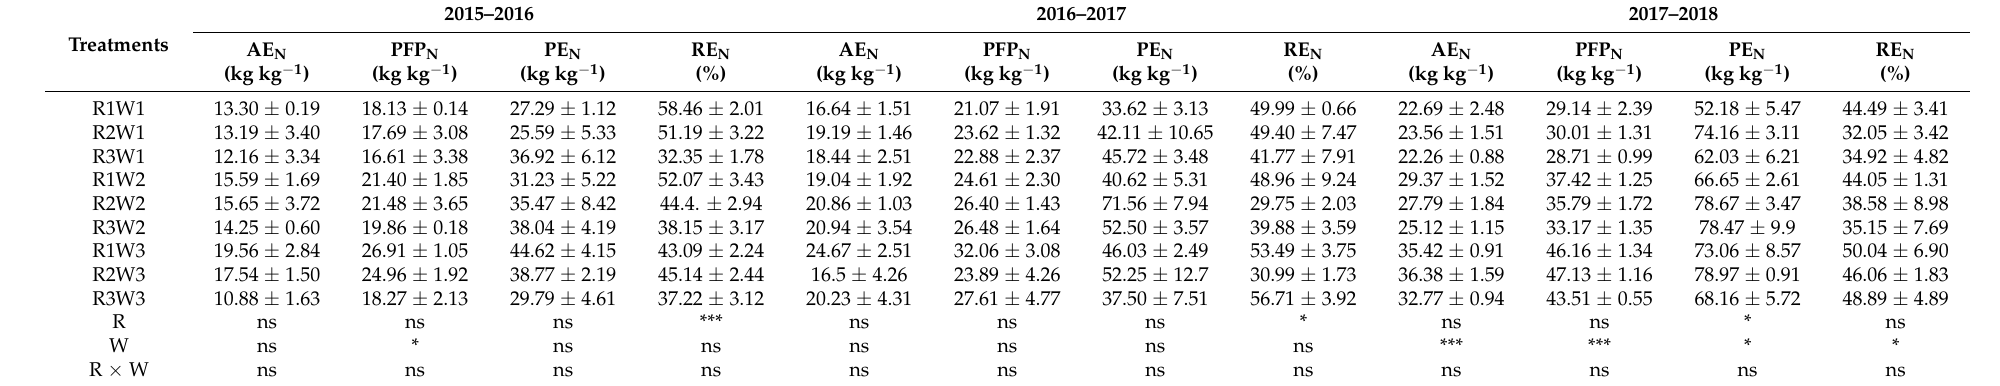
Table 5. Indices of NUE under different N input rates during wheat seasons in the three-year experiment (2016–2018).